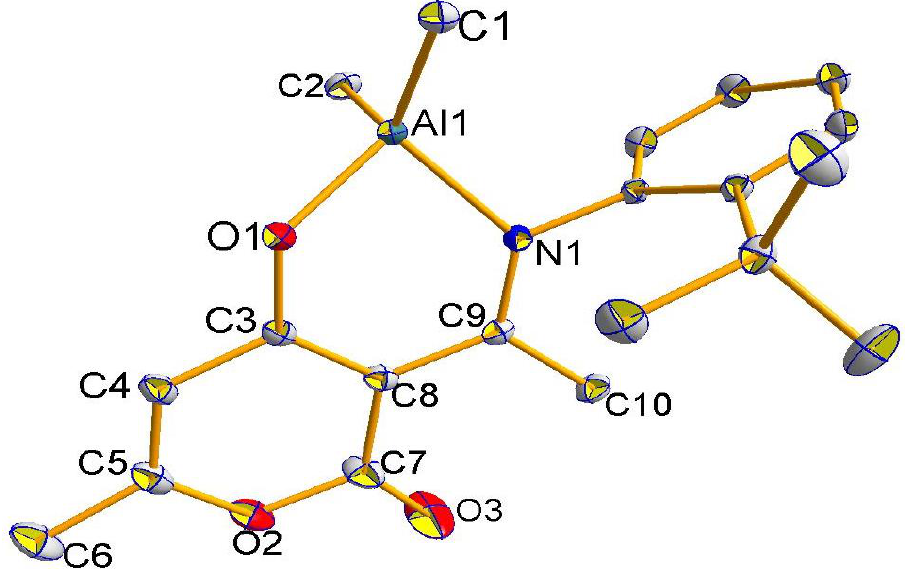
Figure 2. The molecular geometry of compound 1 . Thermal ellipsoids are drawn at the 30% probability level. The hydrogen atoms are omitted for clarity.